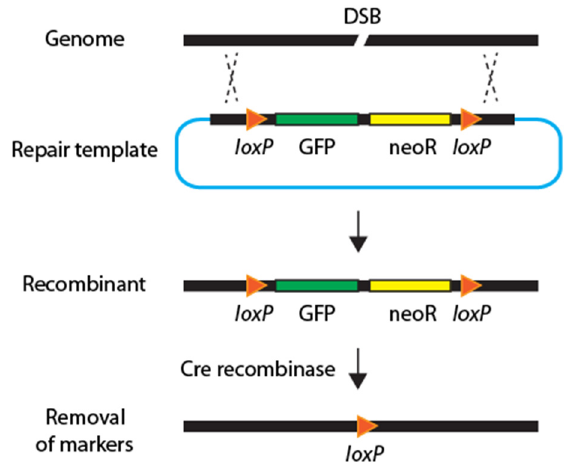
Figure 4. Diagram of streamlined CRISPR-Cas . The streamlined strategies integrate a drug-resistance gene (yellow), a fluorescence marker (green), and a Cre recombinase to facilitate smooth genome editing by removing these two markers.